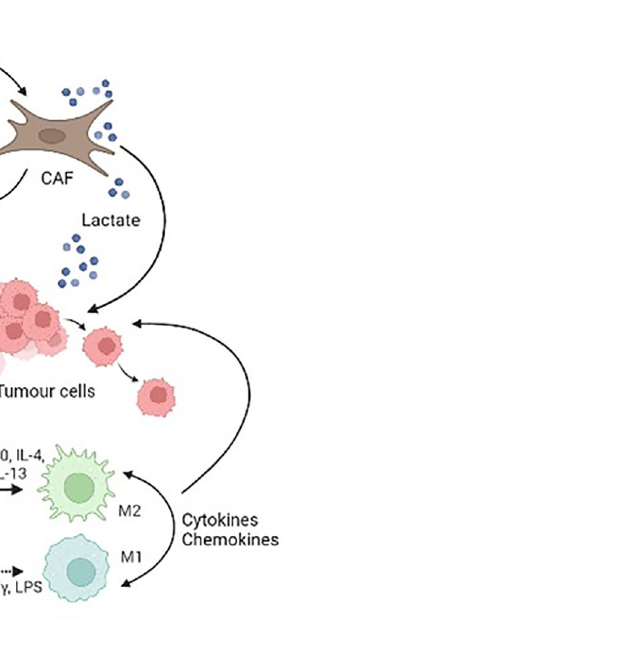
FIGURE 2 Schematic representation of the cellular components of Pheo/PGL tumour